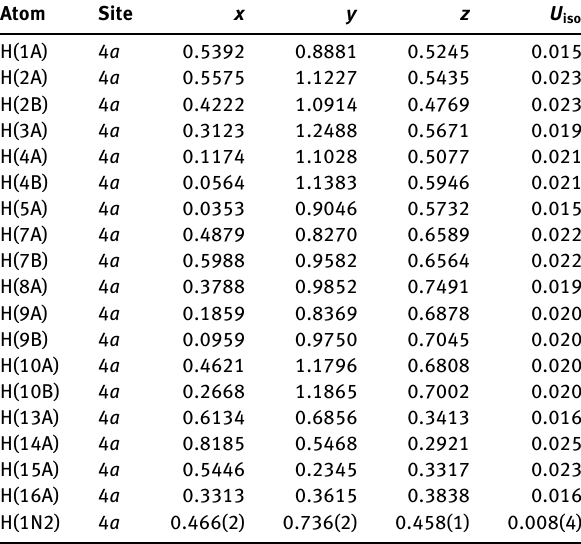
Table 2: Fractional atomic coordinates and isotropic or equivalent isotropic displacement parameters (Å 2